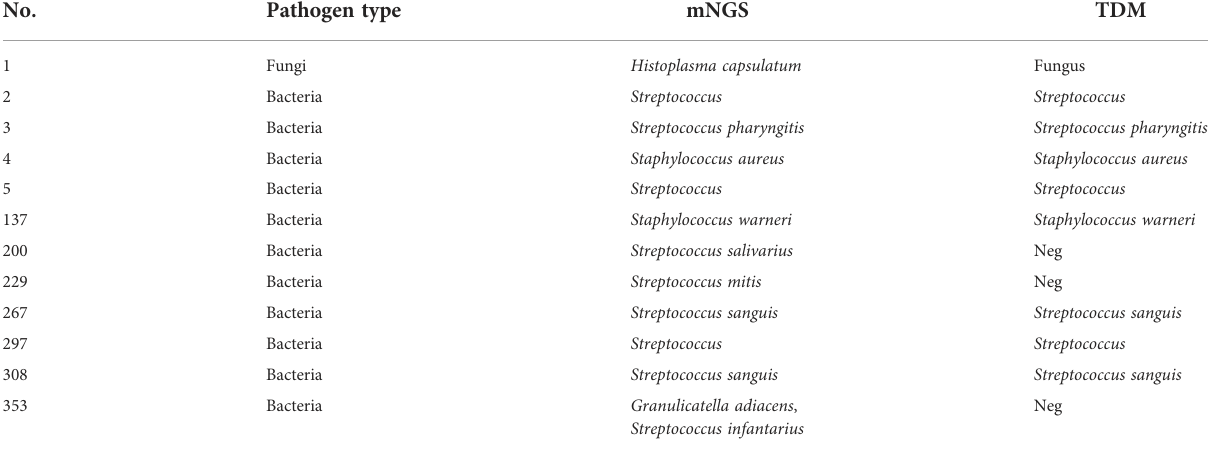
TABLE 1 Analysis of patients with